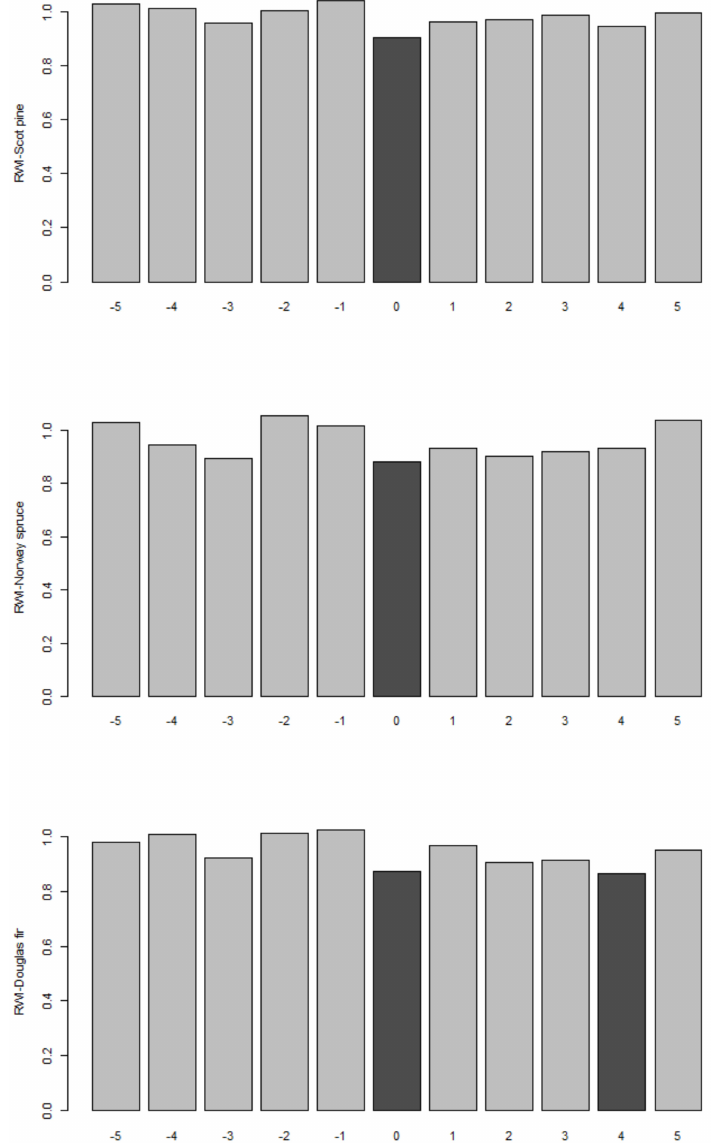
Figure 8. Superposed epoch analysis (SEA) results showing the significant influence of drought events on Scots pine ( Pinus sylvestris ) ( upper ), Norway spruce ( Picea abies ) ( central ), and Douglas fir ( Pseudotsuga menziesii ) ( lower ) growth. In the figure, 0 indicates the event year, − 1 and − 2, and +1 and +2 indicate one year and two years before and following the drought events, respectively. The dark-colored bar indicates significant growth reduction ( p <